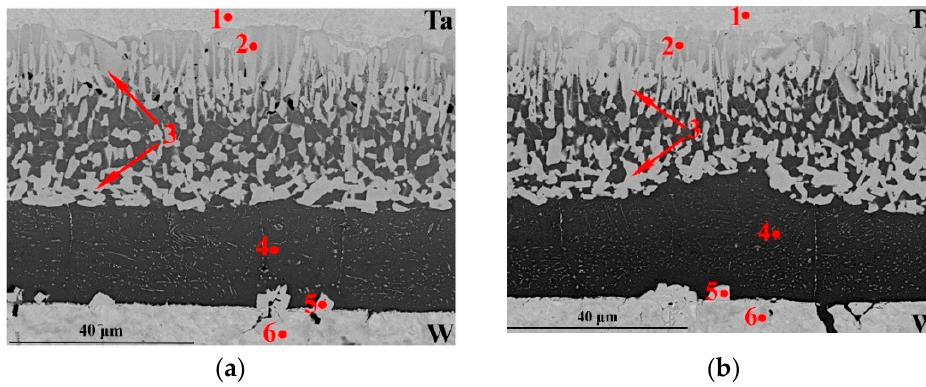
Figure 16. Quantitative SEM analysis represented in Table 1 of Ta/TiZr4B/W seam in: ( a )—as-joined (0) and ( b )—thermo- cycled (200). Table 1. EDS analysis of as-joined (0) and thermo-cycled (200) Rusfer/TiZr4Be/Ta/TiZr4Be/W joints, Figures 15 and 16.